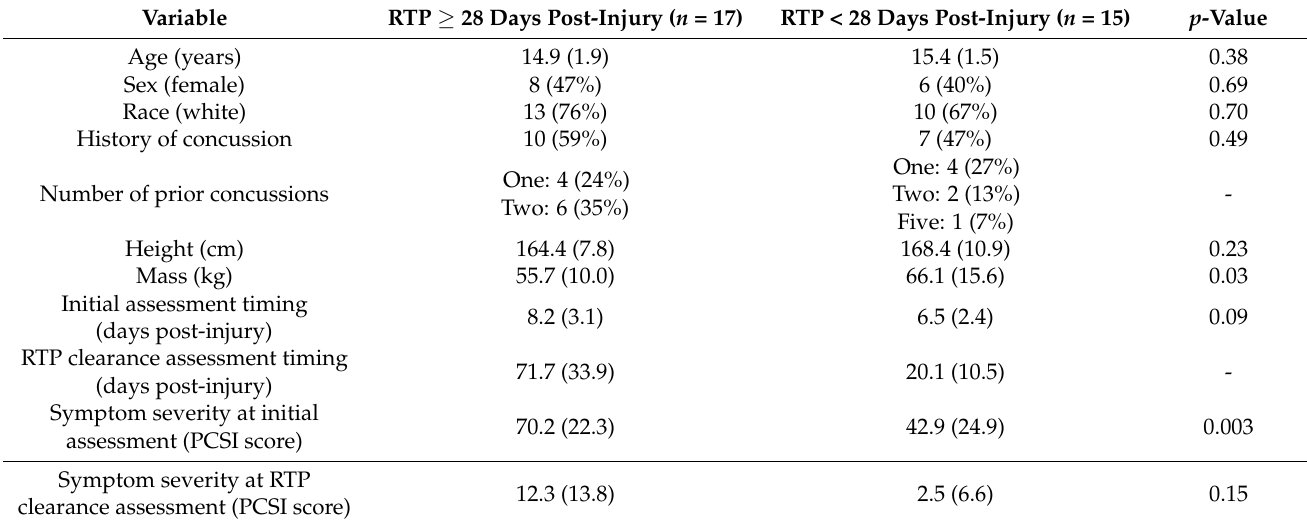
Table 1. Demographic and clinical characteristics between groups. Represented as means (standard